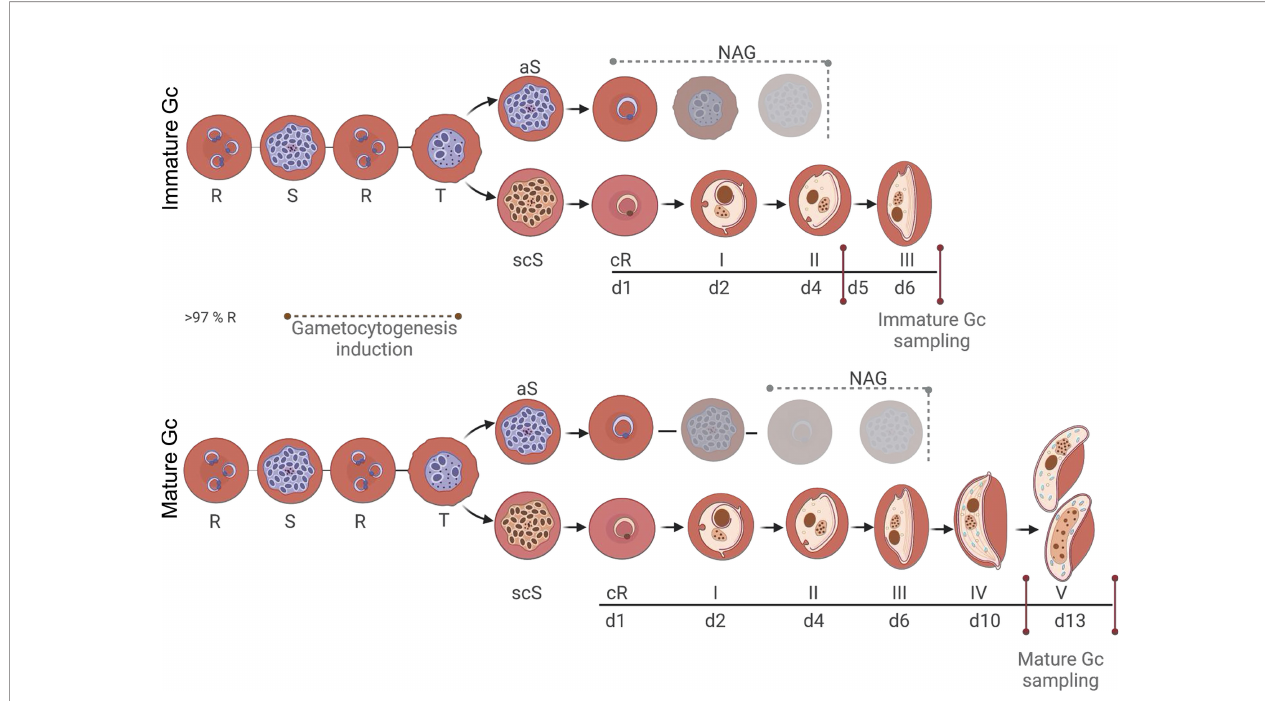
FIGURE 1 | P. falciparum stage-speci fi c gametocyte production and development. Asexual parasites (0.5% parasitemia, 6% hematocrit) were D -sorbitol synchronized for two consecutive cycles to ensure a highly synchronized (>97%) ring population. Initiation of gametocytogenesis (same cycle conversion) was induced on day 0 by a decrease in hematocrit, mimicking anemic conditions. Asexual parasites were eliminated with N -acetyl glucosamine treatment from days 1 to 4 for immature gametocytes and days 3 to 7 for mature gametocytes. Assays were performed on days 5 – 6 or 13 for immature and mature gametocytes, respectively. R-ring, S-schizont, T- trophozoite, aS-asexual schizont, scS-sexual committed schizont, cR-committed ring, Gc-gametocyte. Created and modi fi ed with